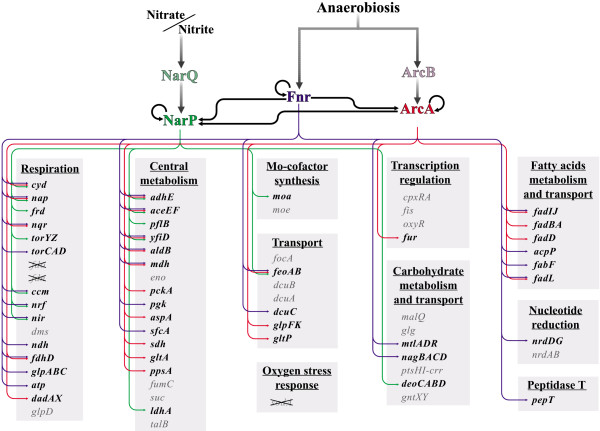
Regulatory interactions in Vibrionaceae. Notation as in Figure 3.